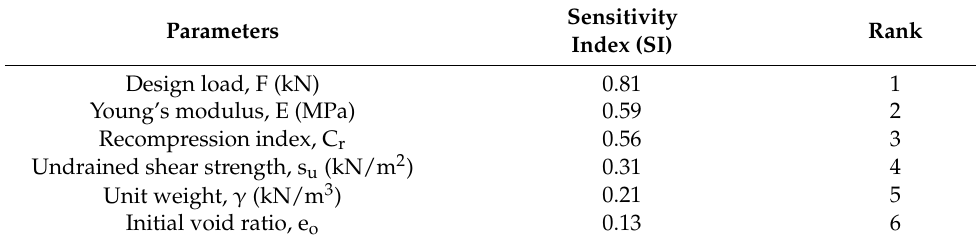
Table 5. Sensitivity indices (SI) of model parameters and corresponding rank.